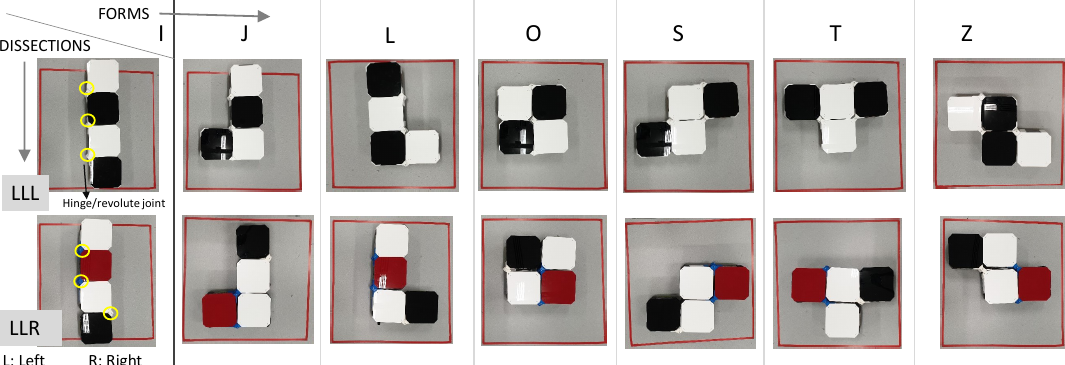
Figure 1. Transformation of hinged dissection of hTetro-LLL and -LLR into all one-sided tetrominoes forms or state labeled as I, J, L, O, S, T and